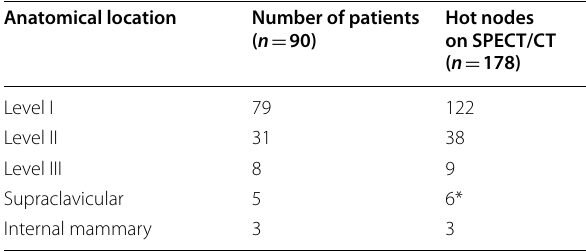
Table 4 Anatomical location of hot nodes on SPECT/CT